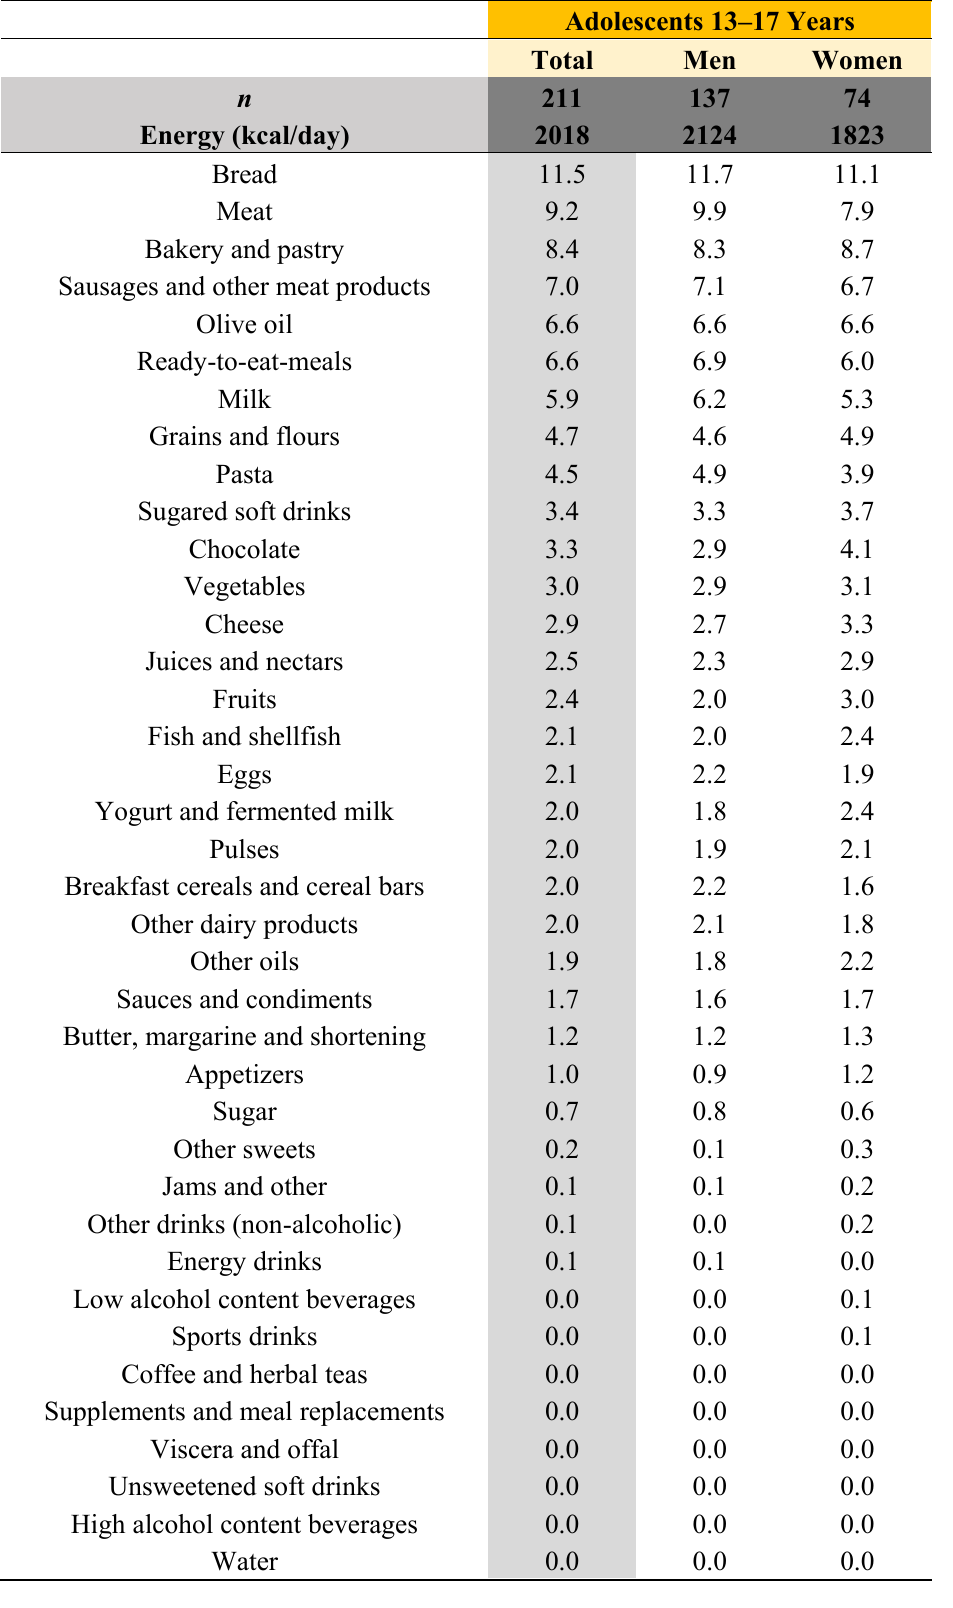
Table 7. Dietary sources of energy (%) from food subgroups in adolescents from the ANIBES survey of the Spanish